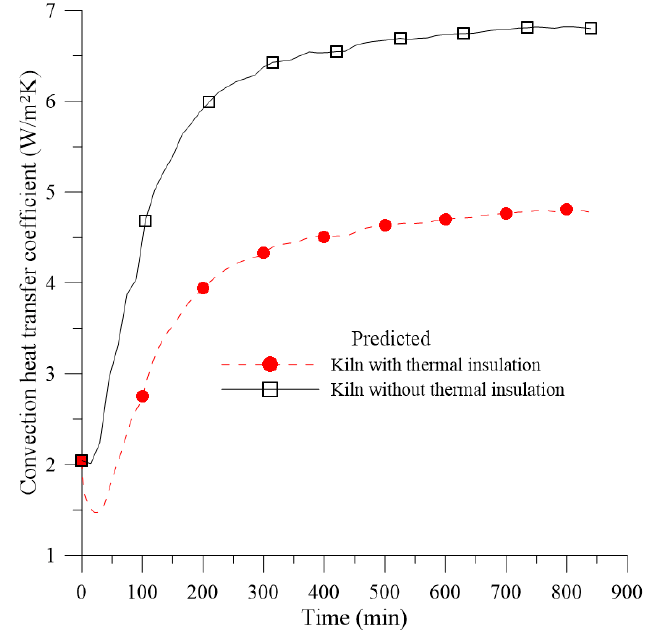
Figure 23. Convective heat transfer coe ffi cient for the kiln with and without thermal insulation as a function of time.